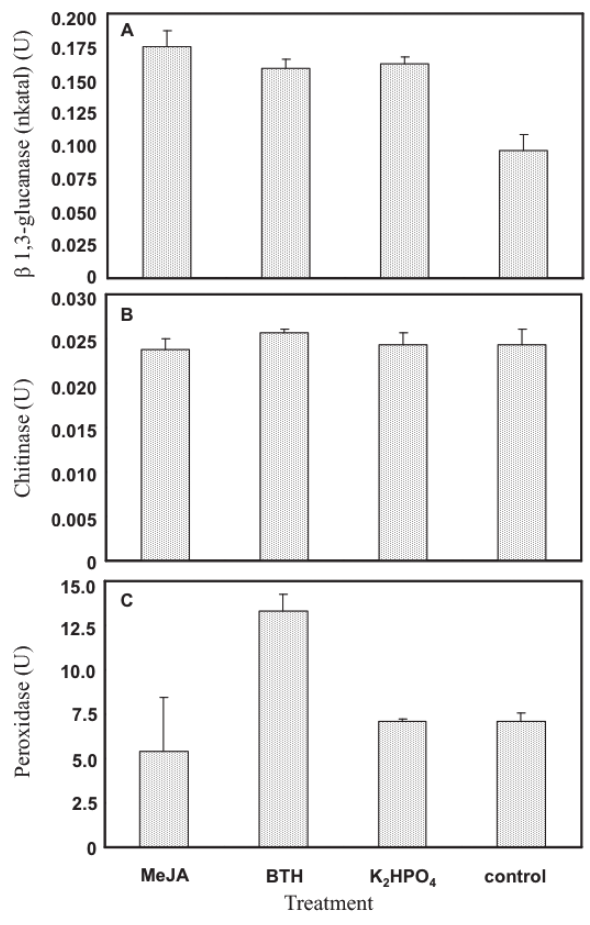
Figure 5. β 1,3-glucanase (A), chitinase (B) and peroxi- dase (C) activities in melon rootlets raised from seed treated with methyl jasmonate (MeJA), acybenzolar- S-methyl (BTH), dipotassium hydrogenphosphate (K HPO ) and water (control) 48h after seed germina- 2 4 tion. data represent the means of two separate